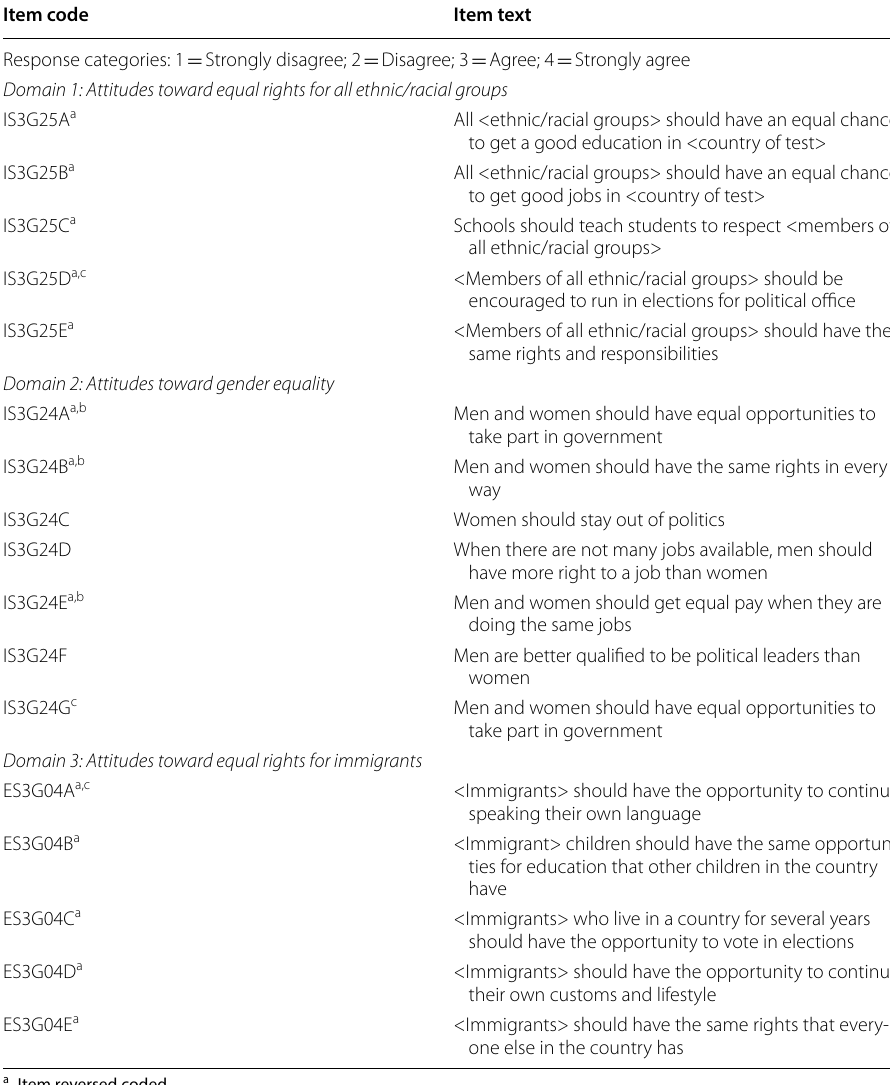
Table 1 Measures of attitudes toward equal